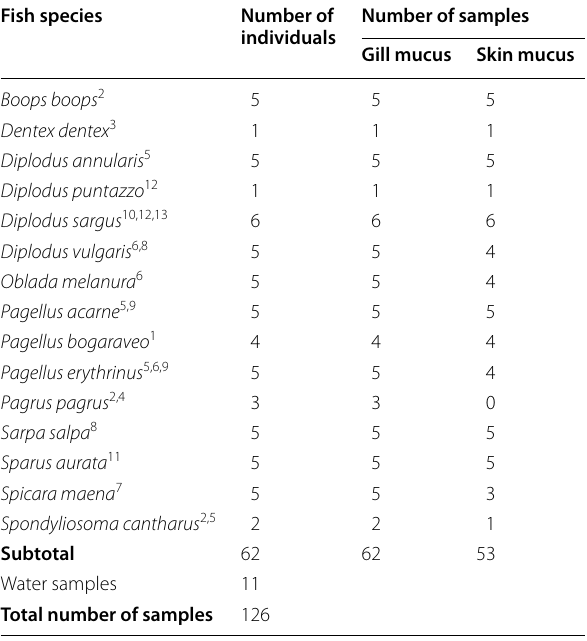
Seawater samples have also been collected at each sampling